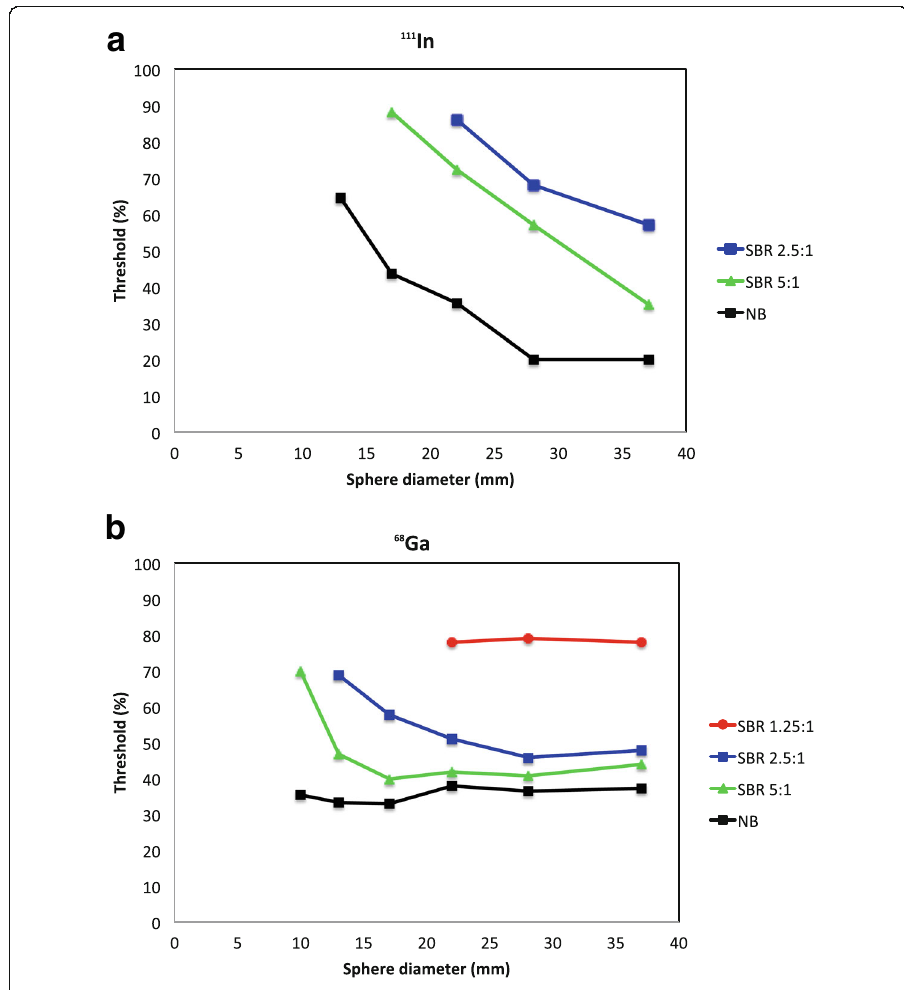
Fig. 5 Threshold level giving the accurate volume for different sphere diameters and SBRs are shown for 111 In-SPECT ( a ) and for 68 Ga-PET ( b ). The data for SBR 1.25:1 was not possible to obtain for 111